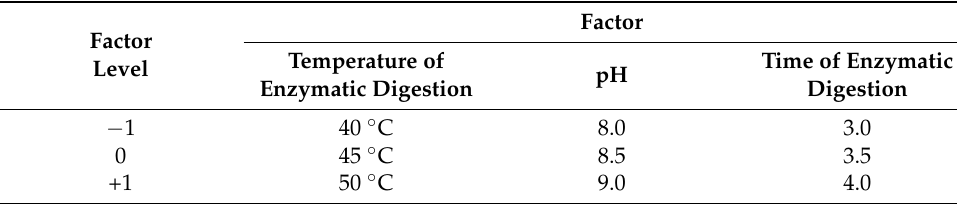
Table 1. Coding values of response surface test factor